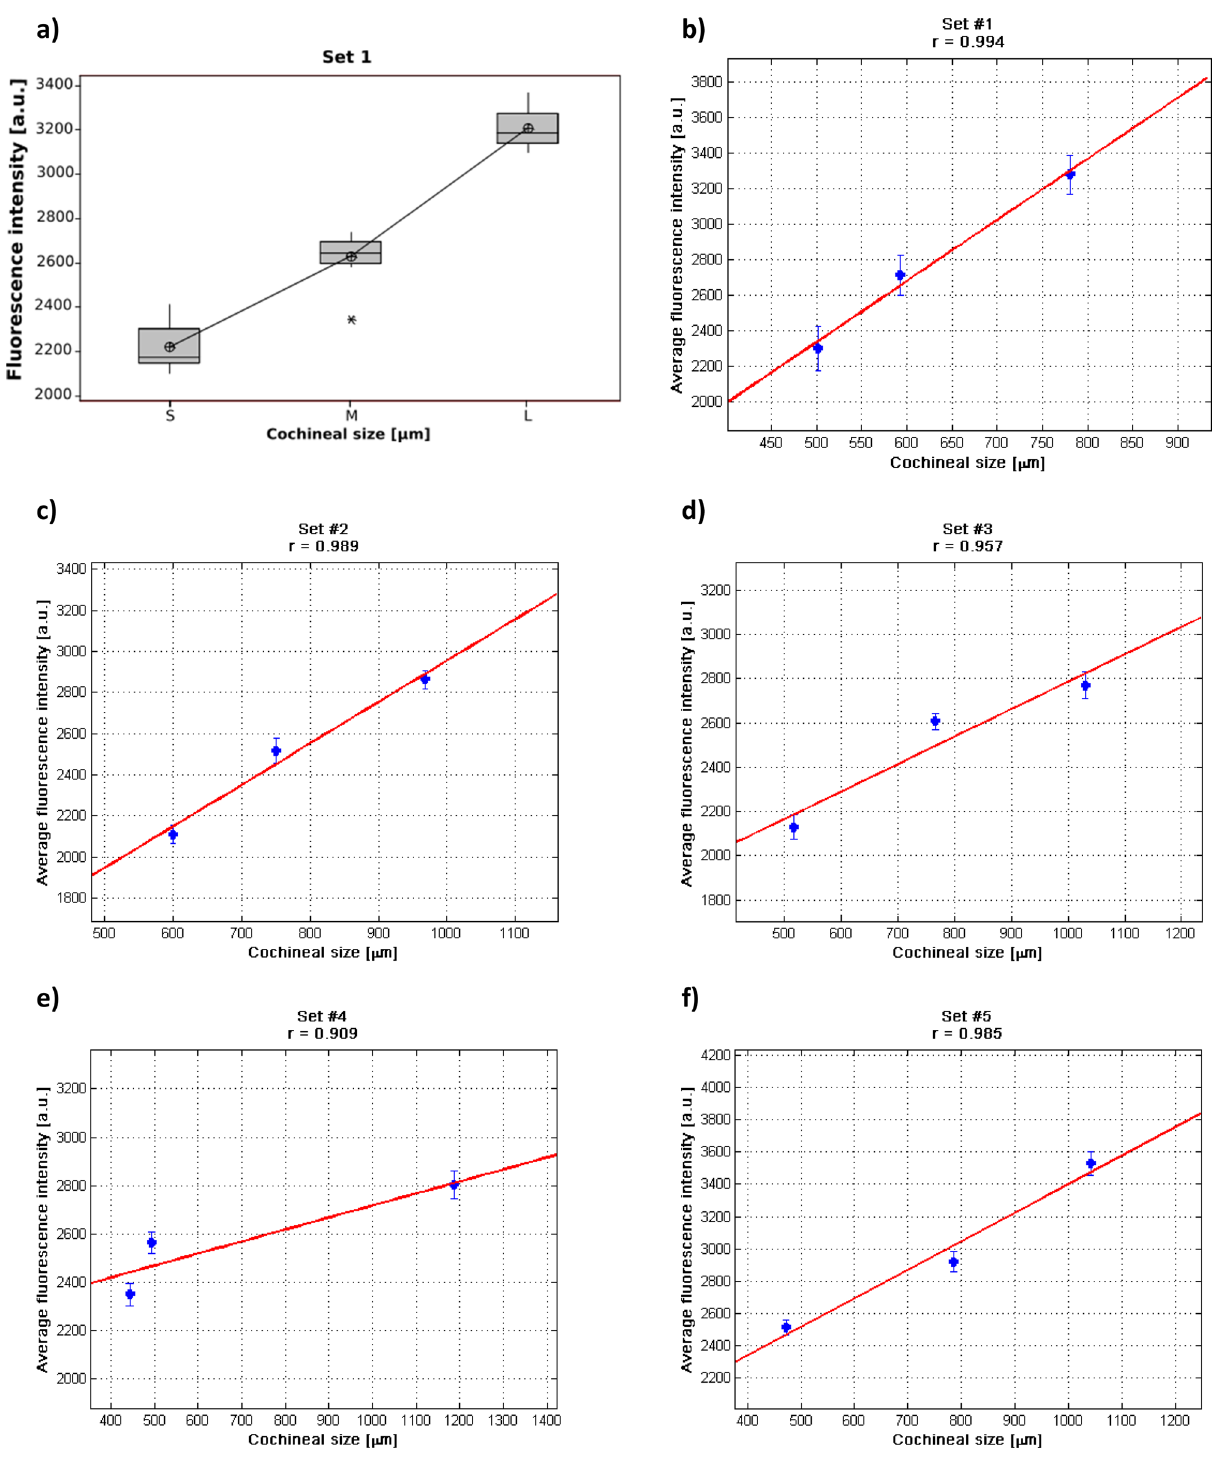
Figure 3. Average fluorescence intensity as function of cochineal size. ( a ) Typical box plot for the set #1 at 620 nm using ANOVA method. ( b – f ) Linear fitting (red line) applied to different repeatability sets 1 to 5, respectively, at the wavelength of 640 nm for each data set (blue dots) using MATLAB, a significant difference in the processed spectra shown in Fig. 2 is